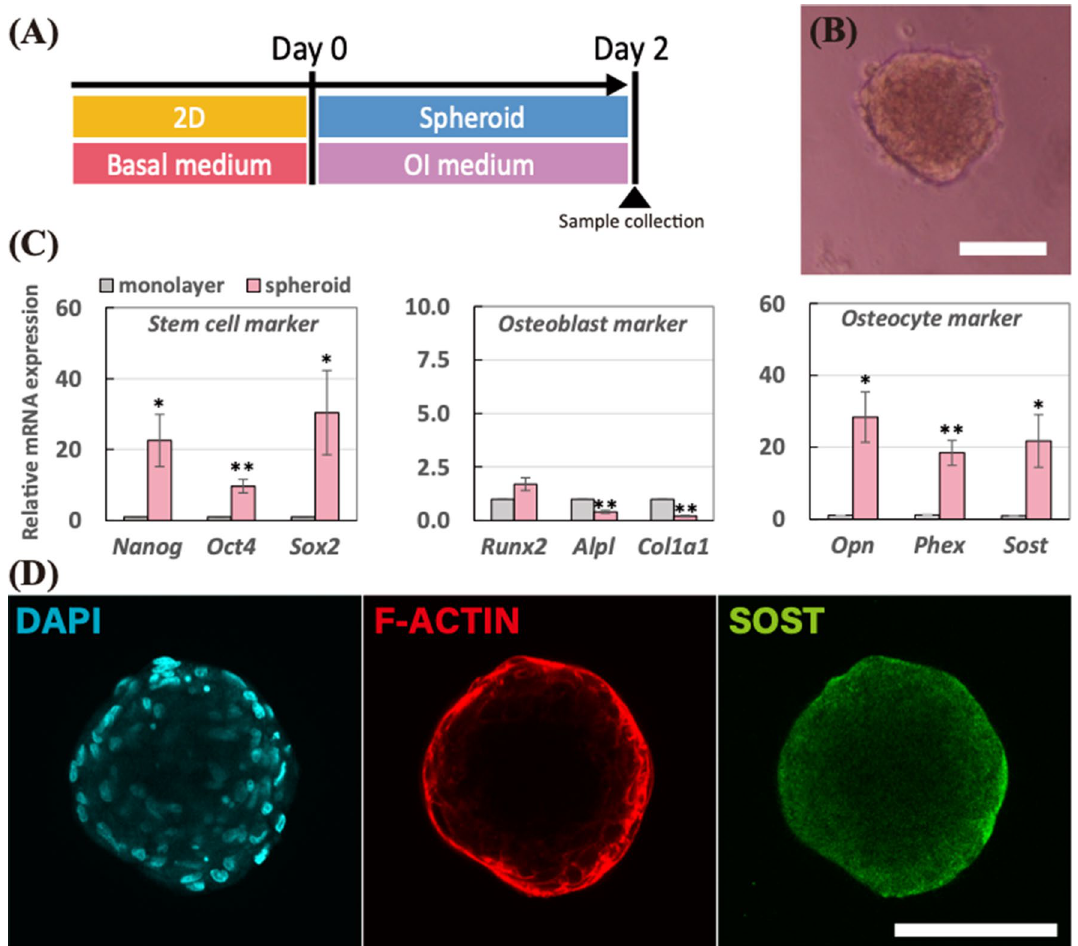
Figure 1. ( A ) Schematic of the experimental time line for spheroids incubated in the osteogenesis induction medium for 2 days. ( B ) Morphology of the spheroid after a 2-day incubation period. The scale bar represents 100 μm. ( C ) Relative mRNA expressions of stem cell markers ( Nanog , Oct4 , and Sox2 ), osteoblast markers ( Runx2 , Alpl , and Col1a1 ), and osteocyte markers ( Opn , Phex , and Sost ) were measured by real-time PCR. All the mRNA expressions were normalized to Gapdh expressions while the results were expressed as relative amounts against the expression of monolayer sample ( n = 8). The bars represent the mean ± standard error. P -value was calculated from Student’s t -test; * p < 0.05, ** p < 0.005. ( D ) Immunostaining images of spheroid after 2-day incubation; cell nuclei (DAPI in cyan), actin filaments (F-Actin in red), and sclerostin (SOST in green). The scale bar represents 100